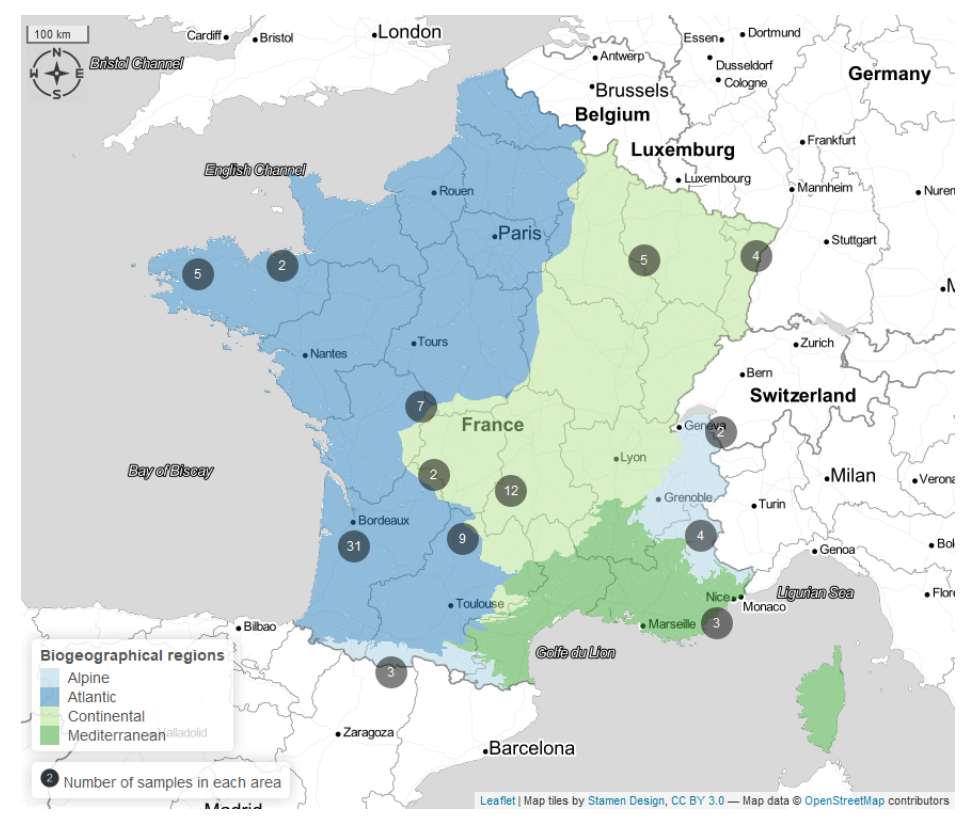
Figure 1. Localization of the sampling sites. The number in the circles indicates the number of samples of small shallow lakes in each area.